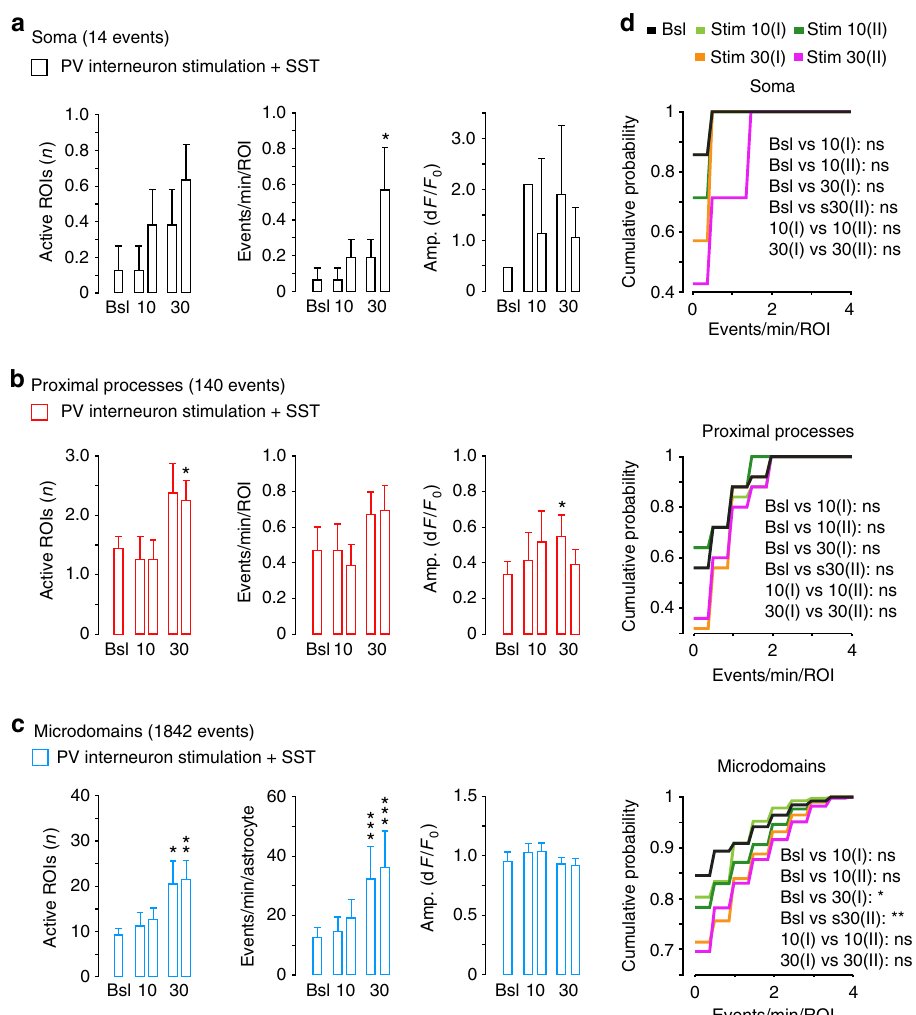
Fig. 7 The neuropeptide somatostatin prevents the depression of the astrocyte response to PV interneurons. a – c Average data of GCaMP6f-astrocyte Ca 2+ response to PV interneuron activation (10 or 30 light pulses) from SSCx slice preparations (8 astrocytes, 8 slices, 3 mice) in the presence of somatostatin (1 – 2 μ M). d Cumulative distributions of Ca 2+ events show no response depression to successive 30 pulse stimulations of PV interneurons (for proximal processes, p = 0.694; for microdomains, p = 0.957, Kolmogorov – Smirnov